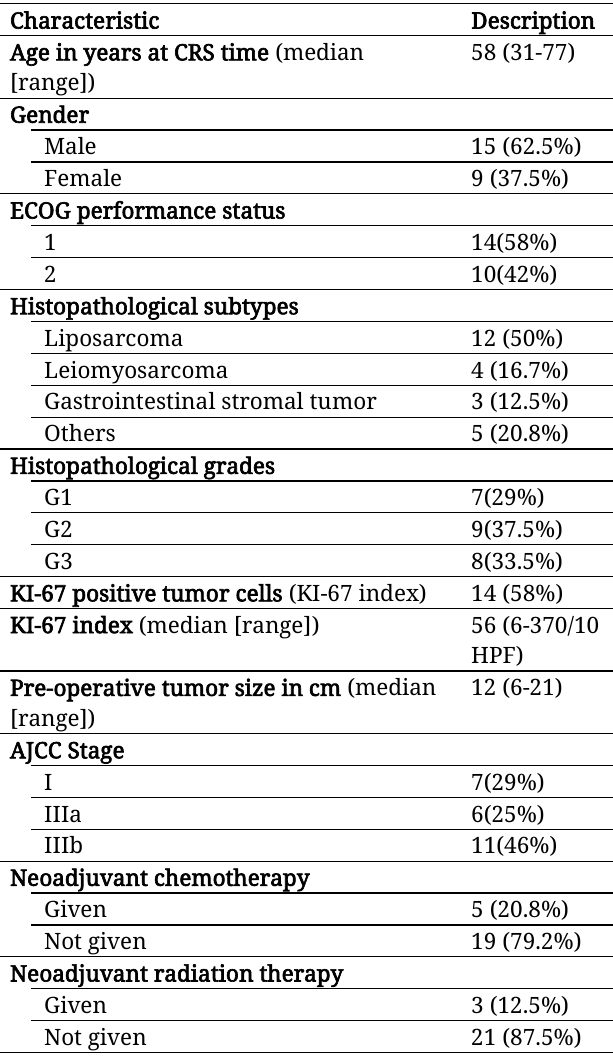
Table 2: Baseline characteristics of 24 patients with peritoneal sarcomatosis and their pre-surgical treatment